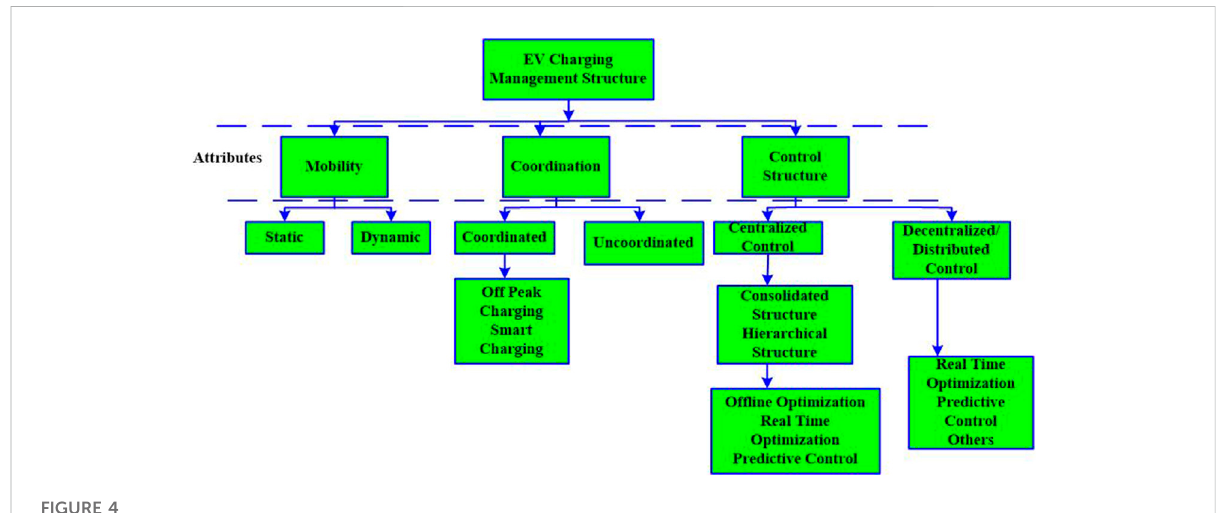
FIGURE 4 EV charging management